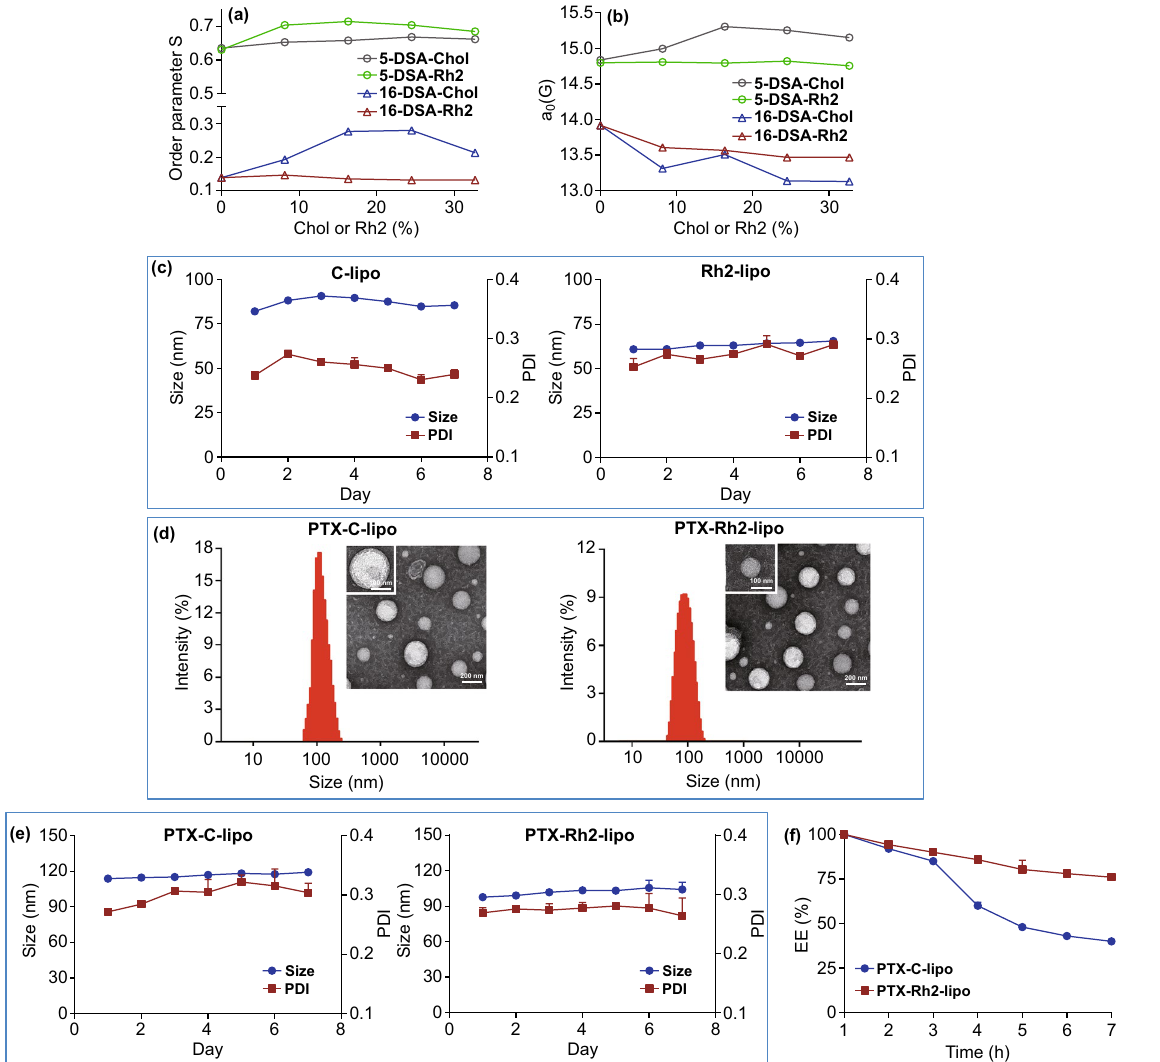
Fig. 2 Rh2 worked as a membrane stabilizer, which keep the stability of liposomes. a Order parameter S of 5-DSA and 16-DSA measured as a function of cholesterol (Chol) or Rh2 concentration. b Isotropic hyperfine coupling constant a 0 of 5-DSA and 16-DSA measured as a function of Chol or Rh2 concentration. c Stability of two blank liposomal formulations kept in 4 °C conditions monitored by dynamic light scattering (DLS) ( n = 3; mean ± SD). d Size distribution of PTX-loaded C-lipo and Rh2-lipo was examined with DLS and TEM. e Stability of two PTX-loaded liposome formulations kept in 4 °C conditions monitored by DLS ( n = 3; mean ± SD). f Drug leakage profiles of PTX loaded C-lipo and Rh2- lipo ( n = 3; mean ±